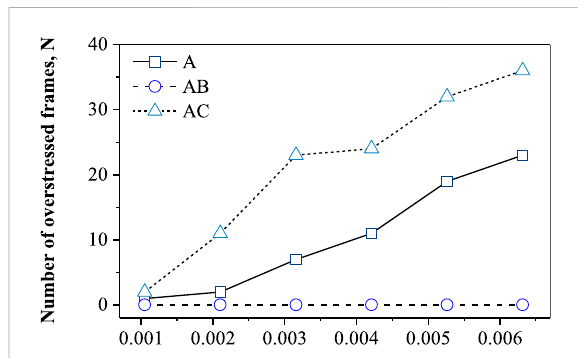
FIGURE 11 Axial force of the corner posts under uneven foundation